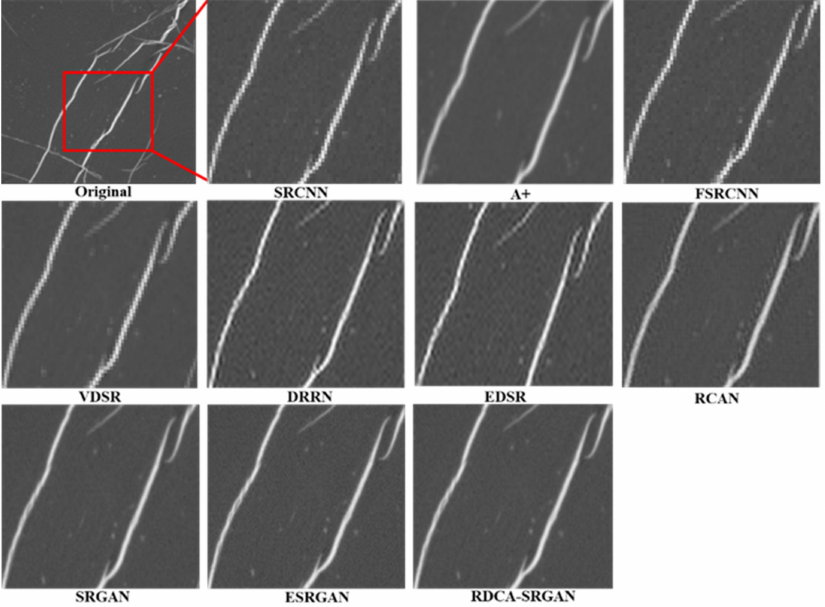
Figure 12. Comparison between HR images on carbon and SR images generated using nine models.